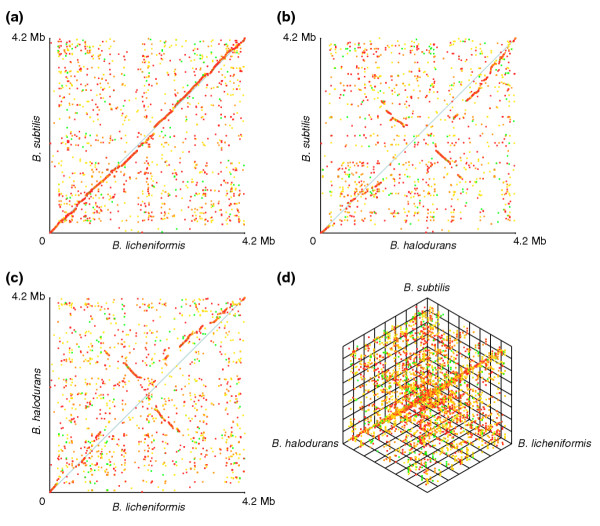
Two- and three-dimensional similarity plots comparing the distribution of orthologs on the chromosomes of B. licheniformis, B. subtilis and B. halodurans. BLAST scores were generated and dots were positioned according to the locations in the genome where orthologs exist in order to view possible regions of possible colinearity. The minimum BLAST expectancy score for each dot in this example was 1 × 10-50. (a) The plot for B. licheniformis versus B. subtilis; (b) B. halodurans versus B. subtilis; (c) B. licheniformis versus B. halodurans; (d) a three-dimensional scatter plot comparing the distribution of orthologs among all three species. Dots located on the diagonal are indicative of conserved location of orthologous genes between species, whereas a line of dots that lie perpendicular to the diagonal suggests an inversion of a genomic segment between species.